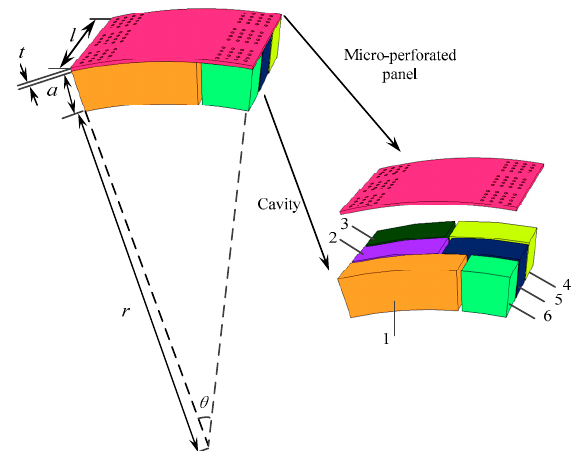
other parameter values were consistent with the original planar BAU structure.